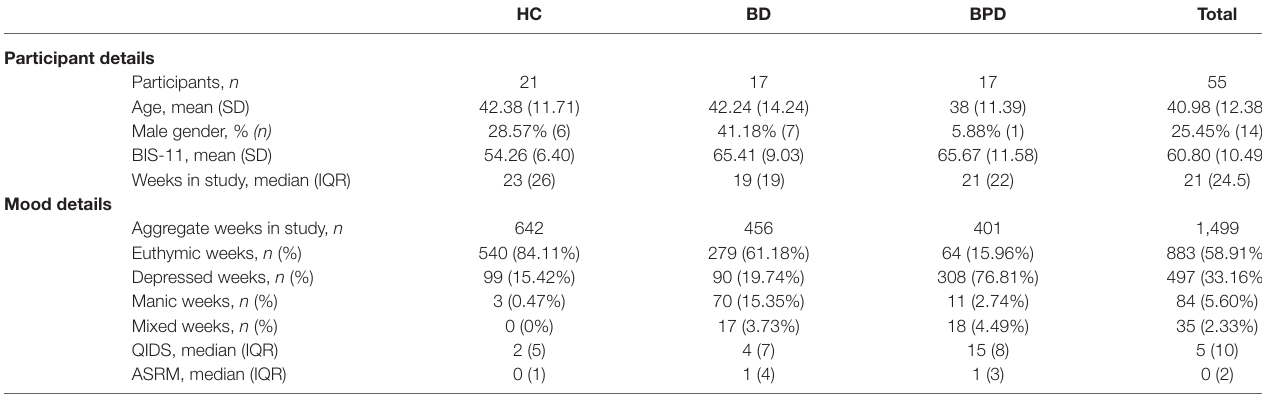
TABLE 1 | Population characteristics and self-rated mood by diagnostic category. HC BD